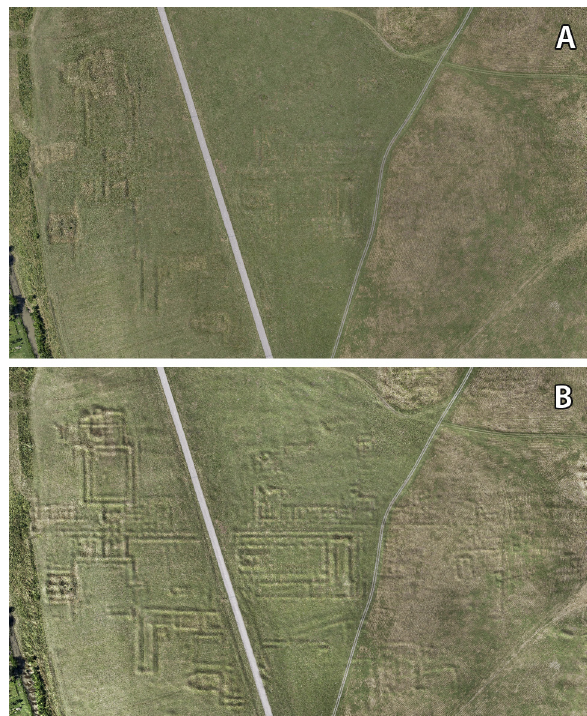
Figure 10. (A) shows the diffuse texture of a landscape surface model representing a part of Bassiana , a Roman city in present- day Serbia. Building traces (created by dug out foundations) are only clearly revealed in the morphology-enhanced texture